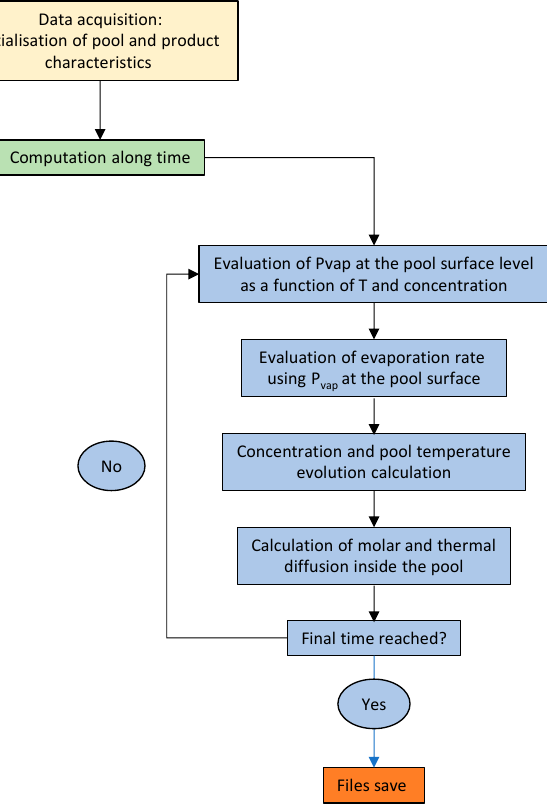
Figure 15. Skeleton of evaporation model.